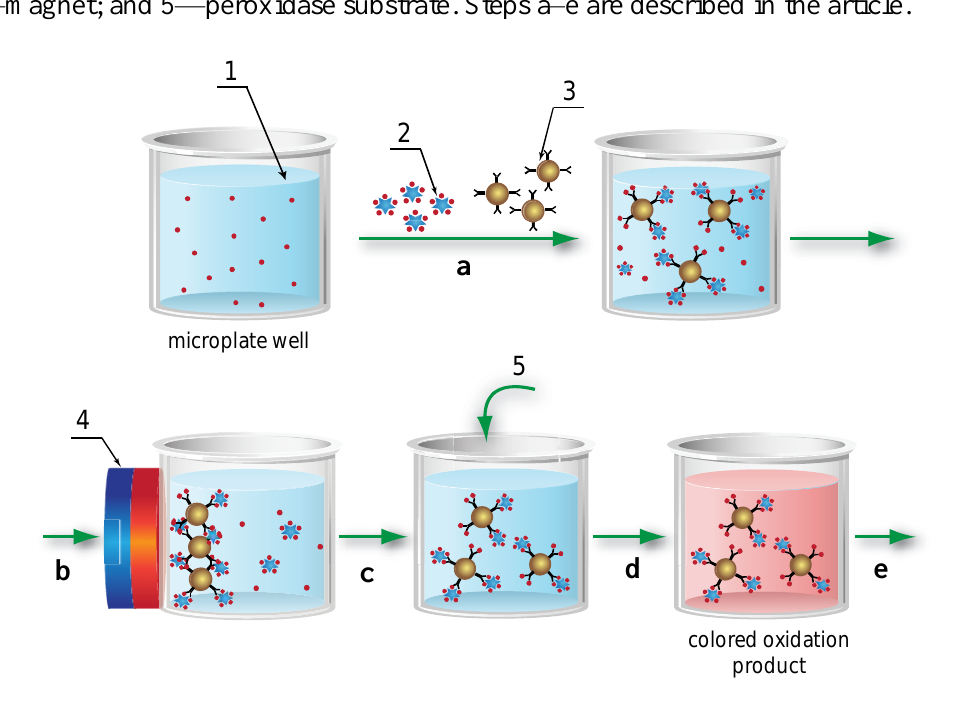
Figure 1. Scheme of ELISA method using magnetic nanoparticles. 1—sample